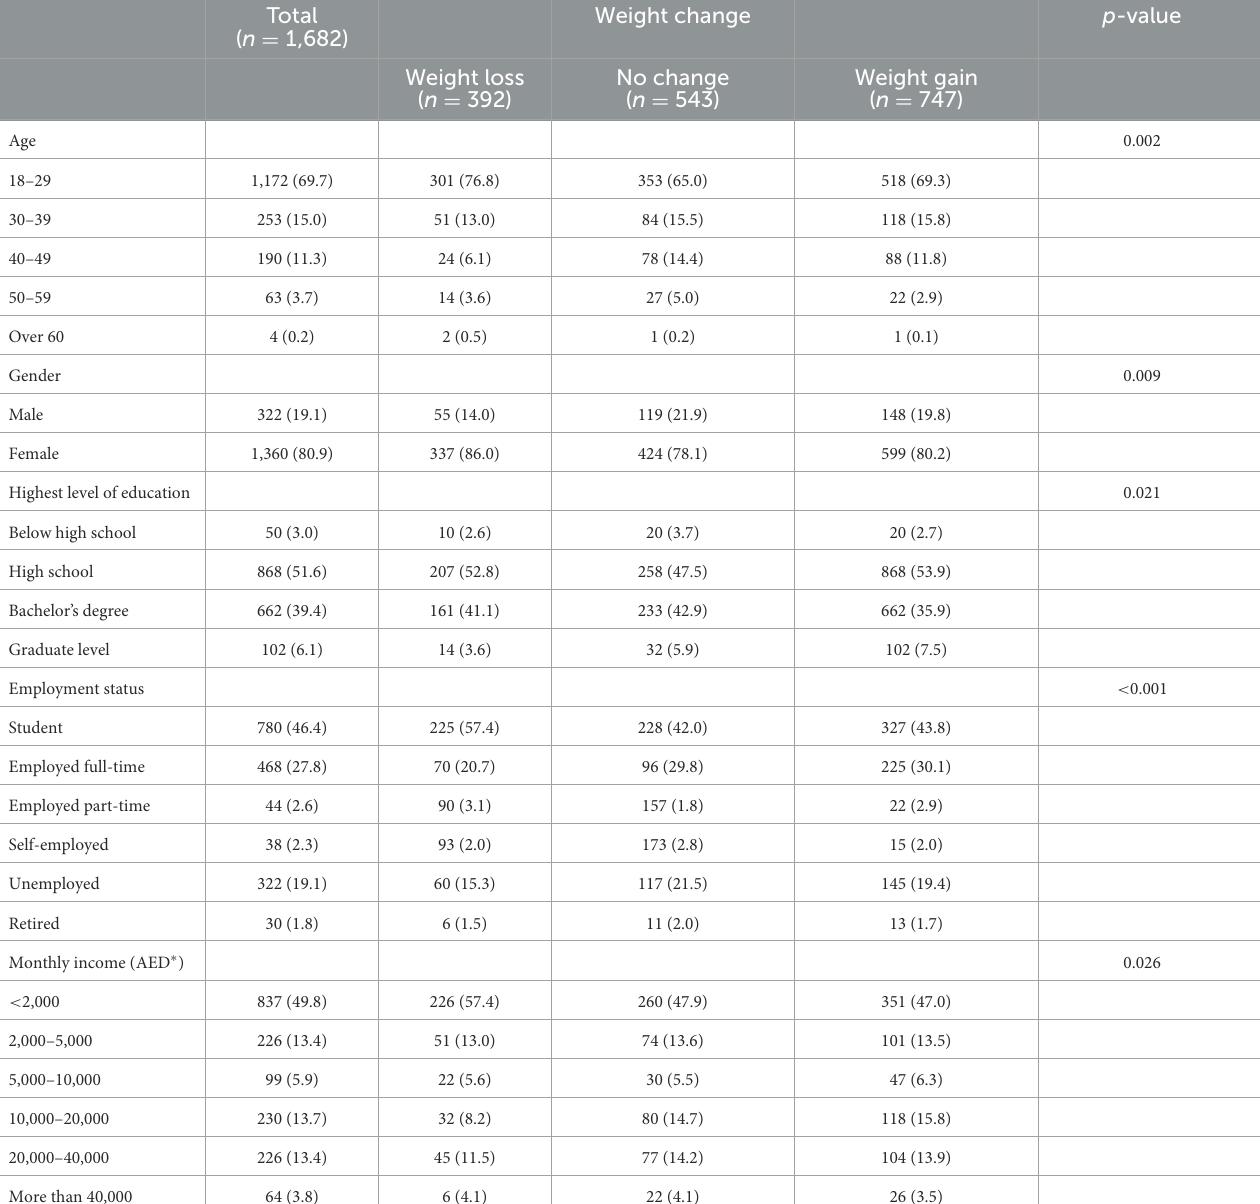
TABLE 2 Changes in weight during COVID-19 according to age, gender, level of education, employment status, and monthly income ( n =